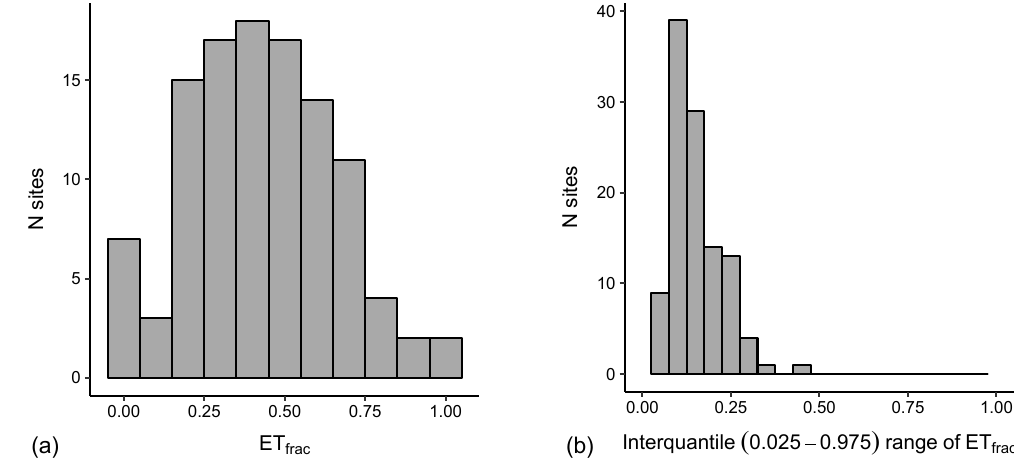
Figure 8. Distribution of the fraction of mean daily transpiration (ET frac ) attributed to the radiation term for all sites, calculated with the parallel approach (a) . Distribution of the within-site variability in ET frac , calculated as the difference between the 97.5 and 2.5 percentiles of the ET frac estimates derived by sampling from the posterior parameter densities parallel approach (b) .